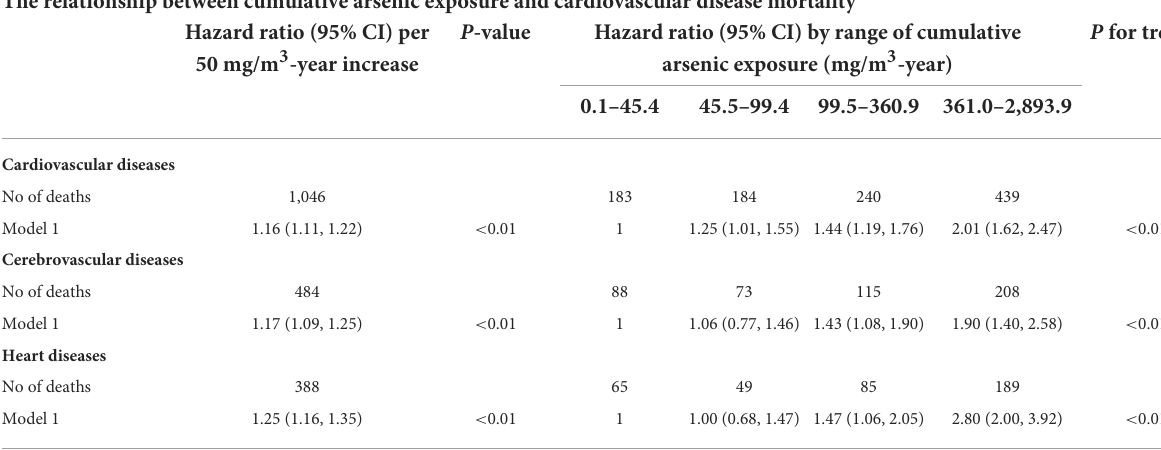
TABLE 4 Patterns of the exposure-response relationship of arsenic-related cardiovascular disease mortality. The relationship between cumulative arsenic exposure and cardiovascular disease mortality Hazard ratio (95% CI)